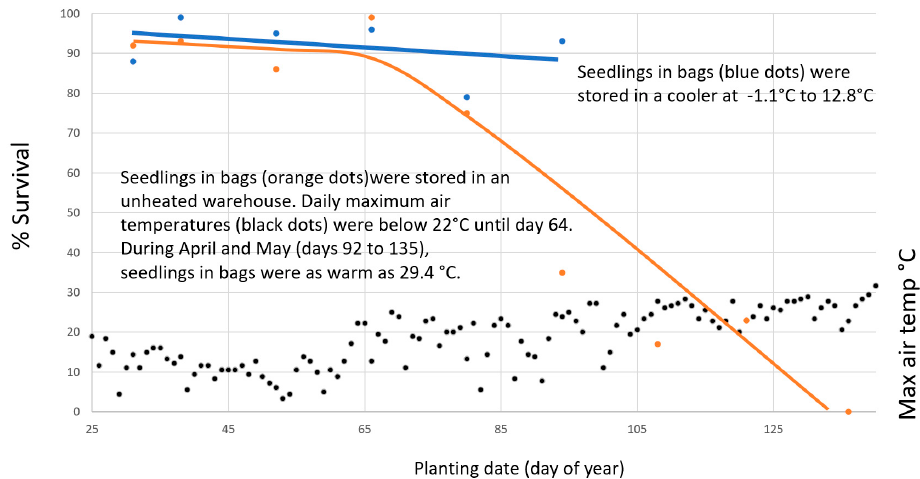
Figure 27. Survival of loblolly pine seedlings is related to the storage method. Data from [176]. Bareroot seedlings lifted on 9 January and cooler-stored for 12 weeks in kraft-polyethylene bags (containing 454 g of sphagnum moss) exhibited good survival when planted at Oxford, Mississippi, on 3 April 1964. The temperature of seedlings stored in an unheated building exceeded 25 ◦ C, and they did not survive well when stored for more than 9 weeks [176]. For the survival of seedlings stored in bags, p > |t| = 0.0001 for intercept and 0.0003 for slope; R 2 = 0.87.